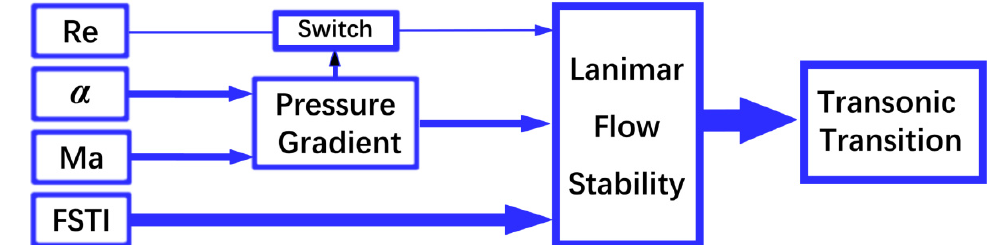
Figure 22. Process of the transition affected by the sensitivity factors and relationship between the sensitivity factors.